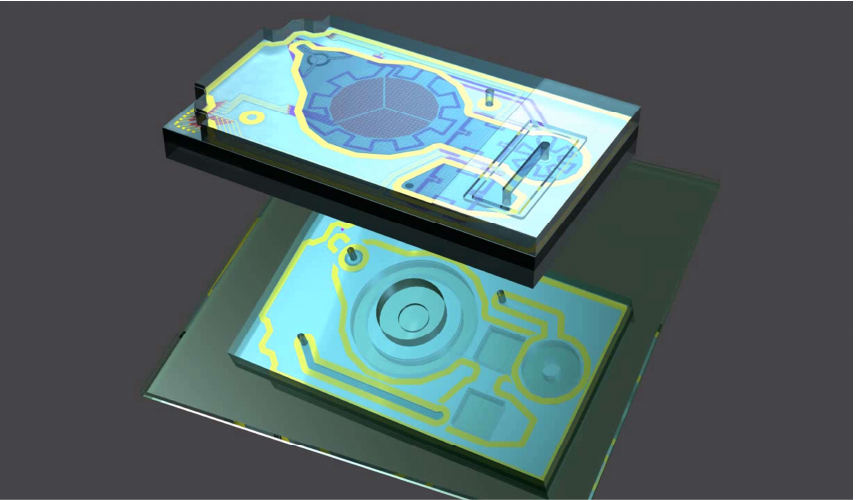
Figure 1. Schematic view of Debiotech’s triple-stack micropump with electrical routing and bonding structures. The chip dimensions in mm are 10.08 × 5.84 × 1.416 (𝐿 × 𝑊 × 𝐻) .